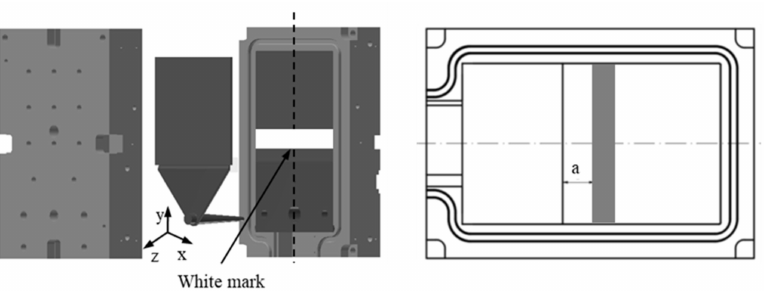
Figure 1. Studied object.